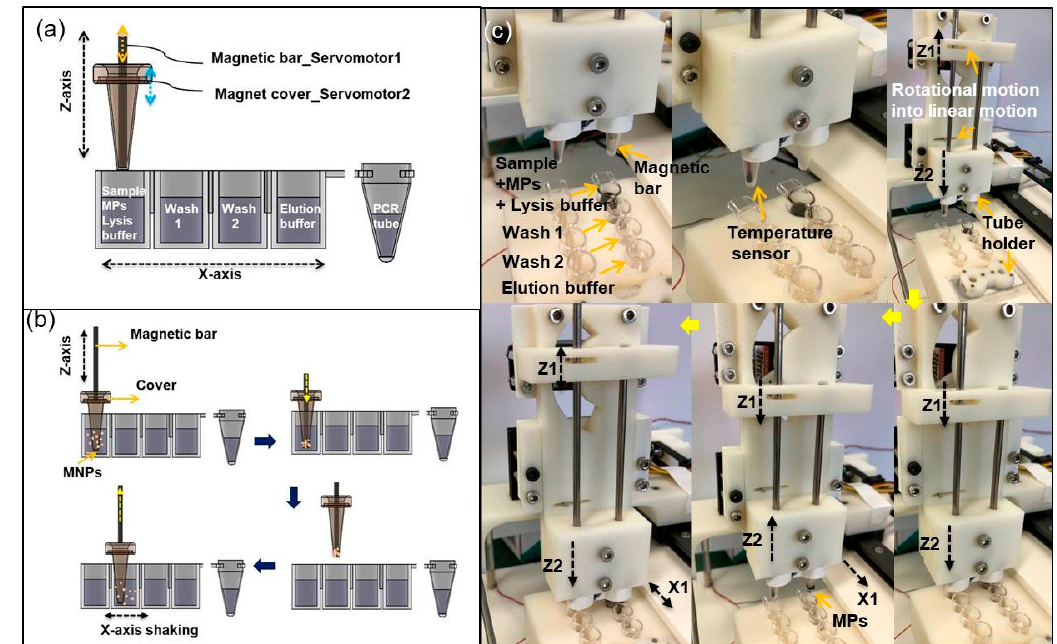
Figure 2. Schematic images of ( a ) cross-sectional view of a sample cartridge and ( b ) automated workflows including mixing, capturing, transport, and dispersion. The cartridge has four wells: lysis buffer, washing I, washing II, and elution buffer for automated sample preparation, and a conical PCR microtube for DNA amplification. ( c ) Photographs of each step for magnetic particle (MP) transport and re-dispersion to next well.